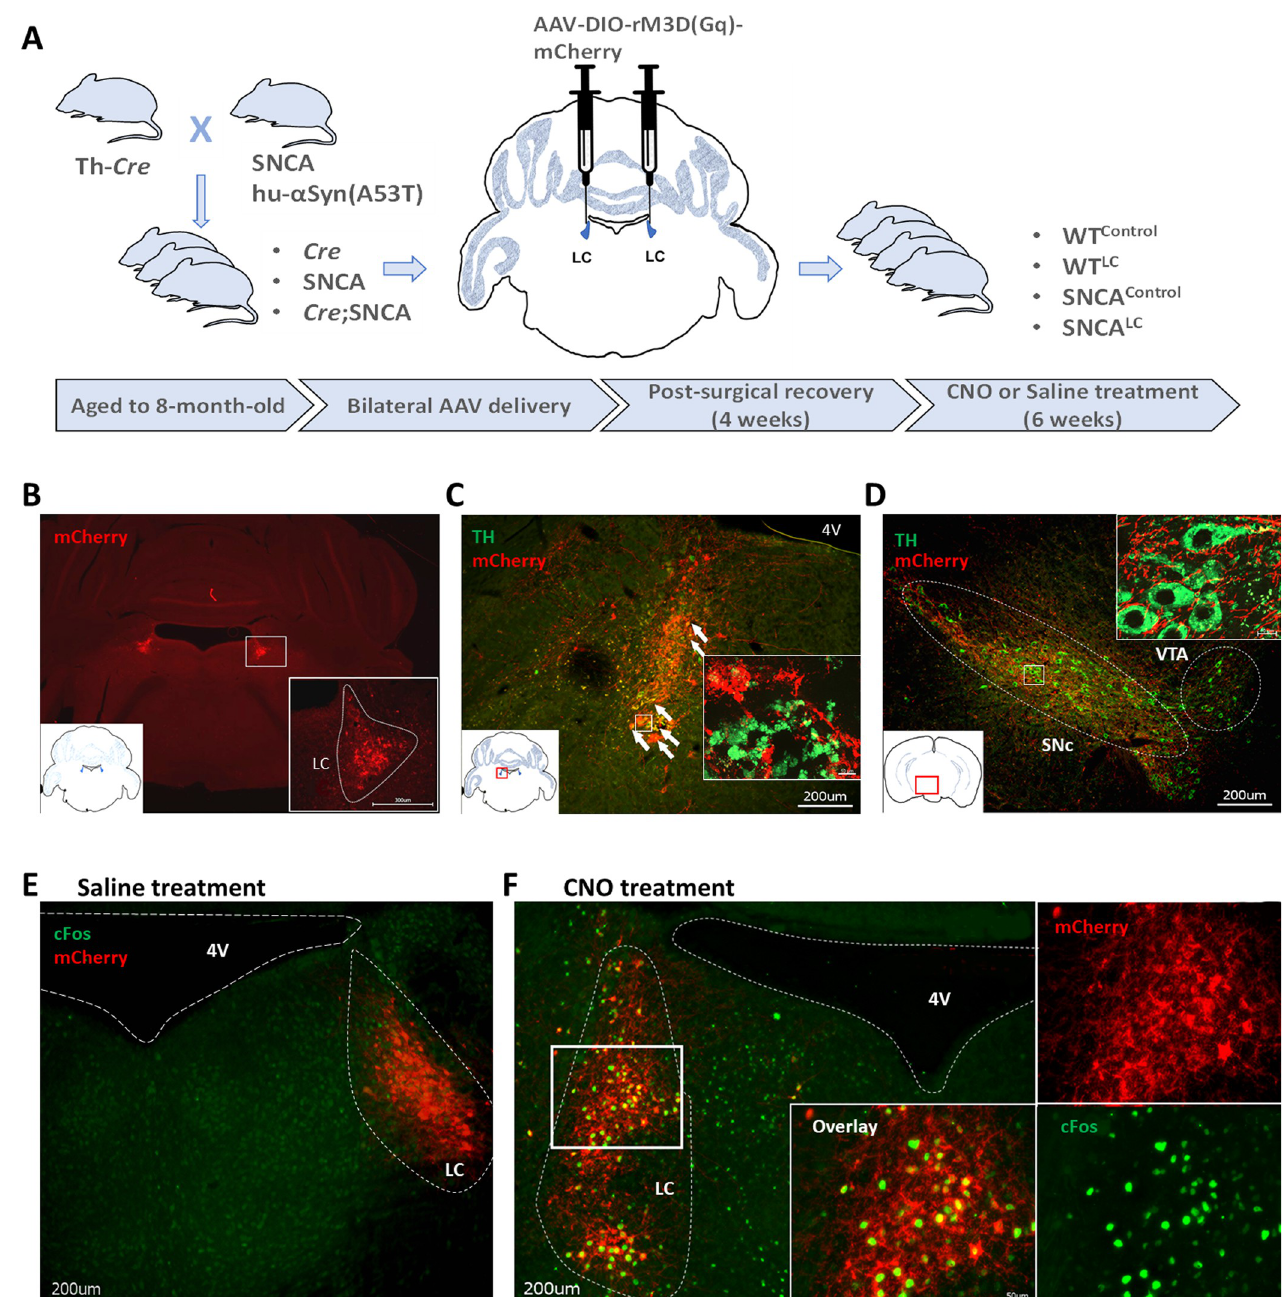
Fig 1. Chronic stimulation of LC-NE neurons using hM3D-DREADD. A- Experimental approach to chronically activate LC-NE neurons. B- Coronal section showing mCherry labeled neurons (red) at the injection sites (locus coeruleus), scale bar 300 μ m. C- Representative image showing colocalization of mCherry (red) and TH positive cells (green) in locus coeruleus, scale bar 200 μ m. D- Representative image showing LC-NE projections to substantia nigra, mCherry positive fibers (red), TH positive cells (green), scale bar 200 μ m. E, F-Activation of TH neurons in LC, transduced with AAV containing double floxed Gq- coupled hM3D DREADD fused with mCherry under the control of human synapsin promoter, upon injection of saline or CNO, respectively, mCherry (red) and c-Fos positive cells (green) in locus coeruleus, scale bar 50 μ m and 200 μ m.